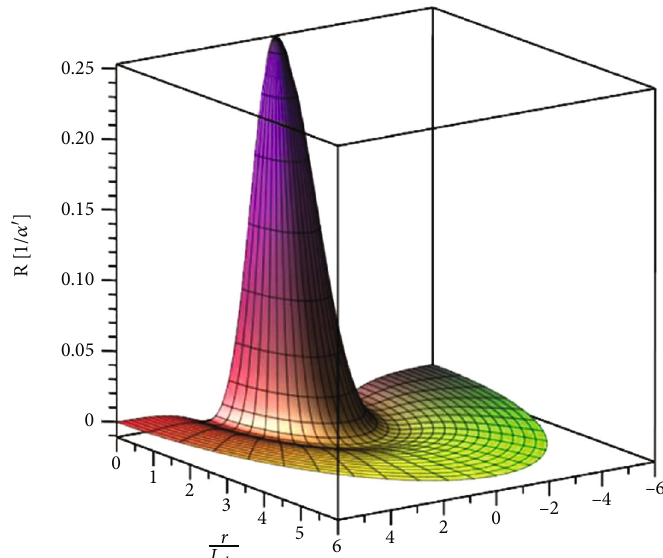
M gluon , and θ . The mass of dyon